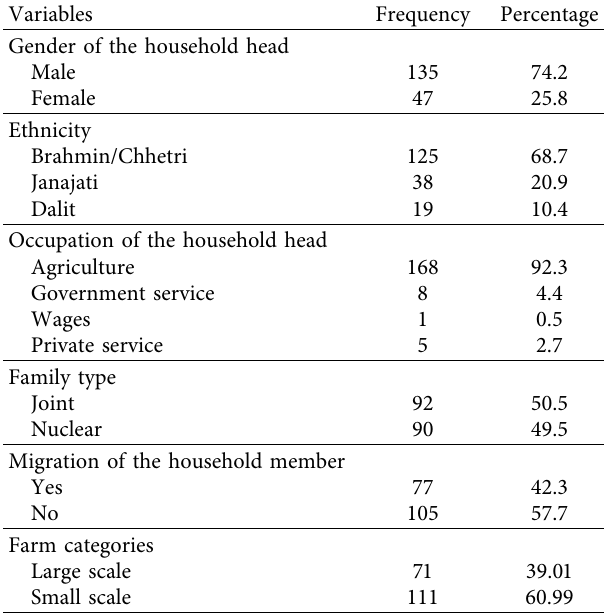
Table 2: Socioeconomic and demographic characteristics of the sampled households (categorical